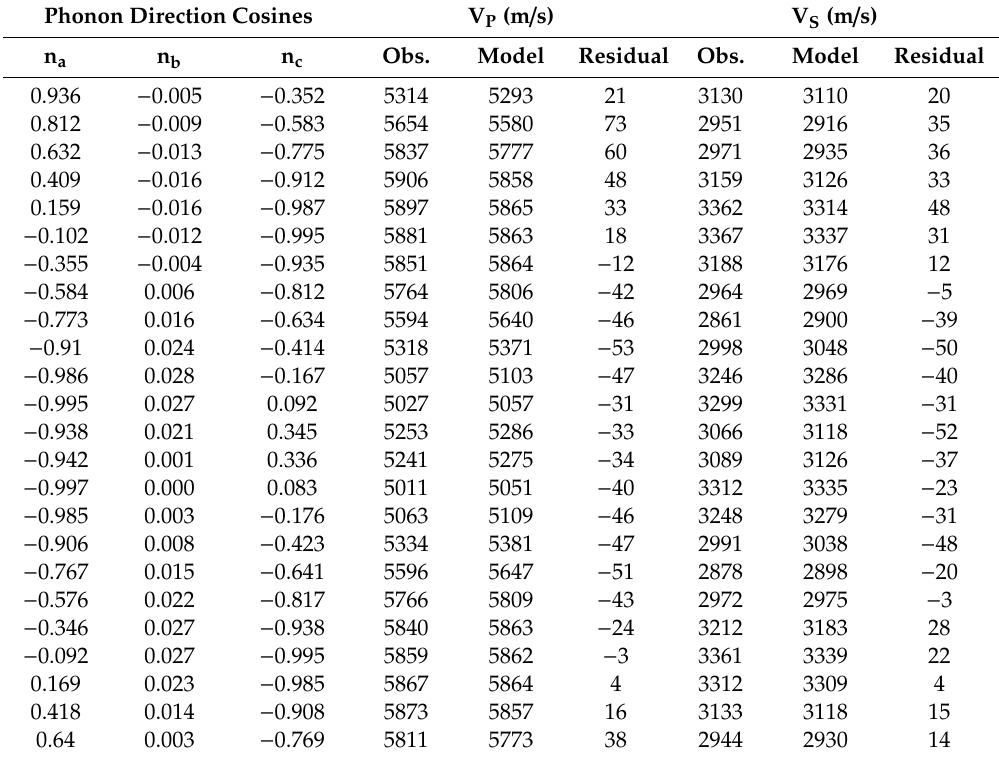
Figure 2. Measured acoustic velocities of hemimorphite (solid symbols), as a function of crystallographic directions projected onto the a–b, b–c, and a–c crystallographic planes. Squares and circles represent V P and Vs measurements, respectively. The red symbols are measured on (001), (100) and (010); blue symbols are measured on the (001), (00) and (010). The best-fit acoustic velocity model is shown by solid lines. Error bars are smaller than the size of symbols. Table 1. Acoustic measurements of hemimorphite at ambient conditions.